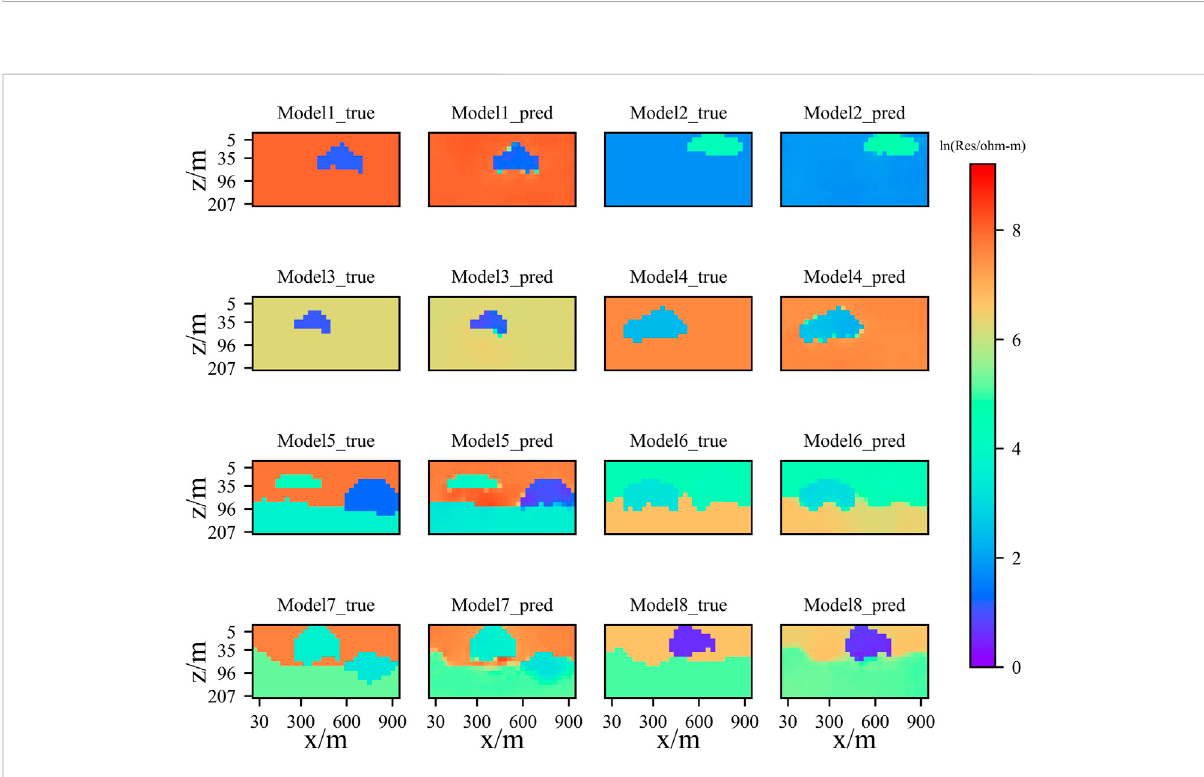
Imaging results for training sets of different